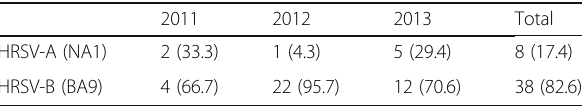
Table 1 Distribution of respiratory syncytial virus genotypes